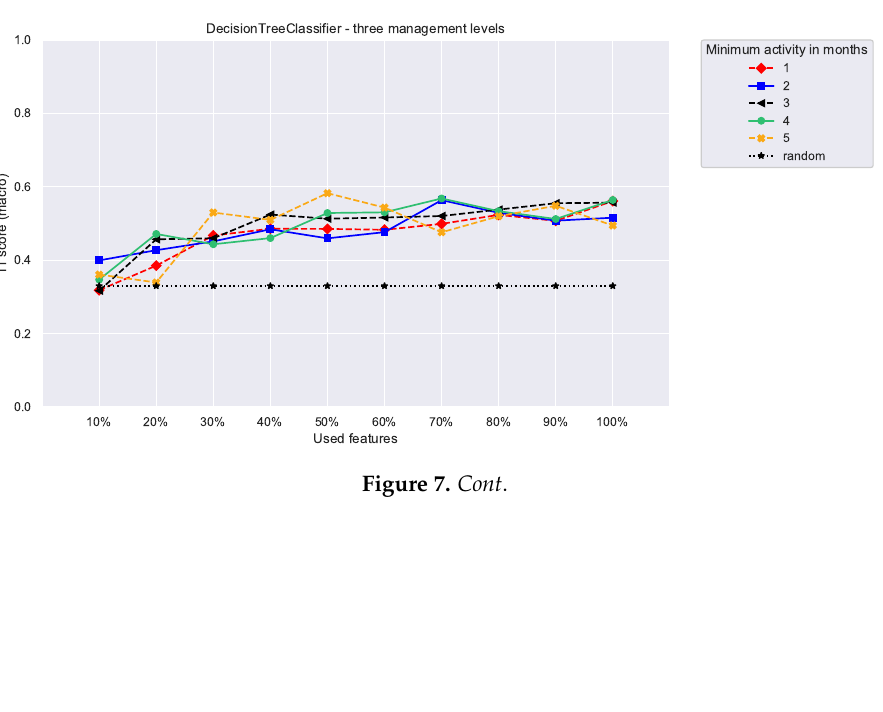
Figure 6. The result of the classification of two groups for the Enron dataset.